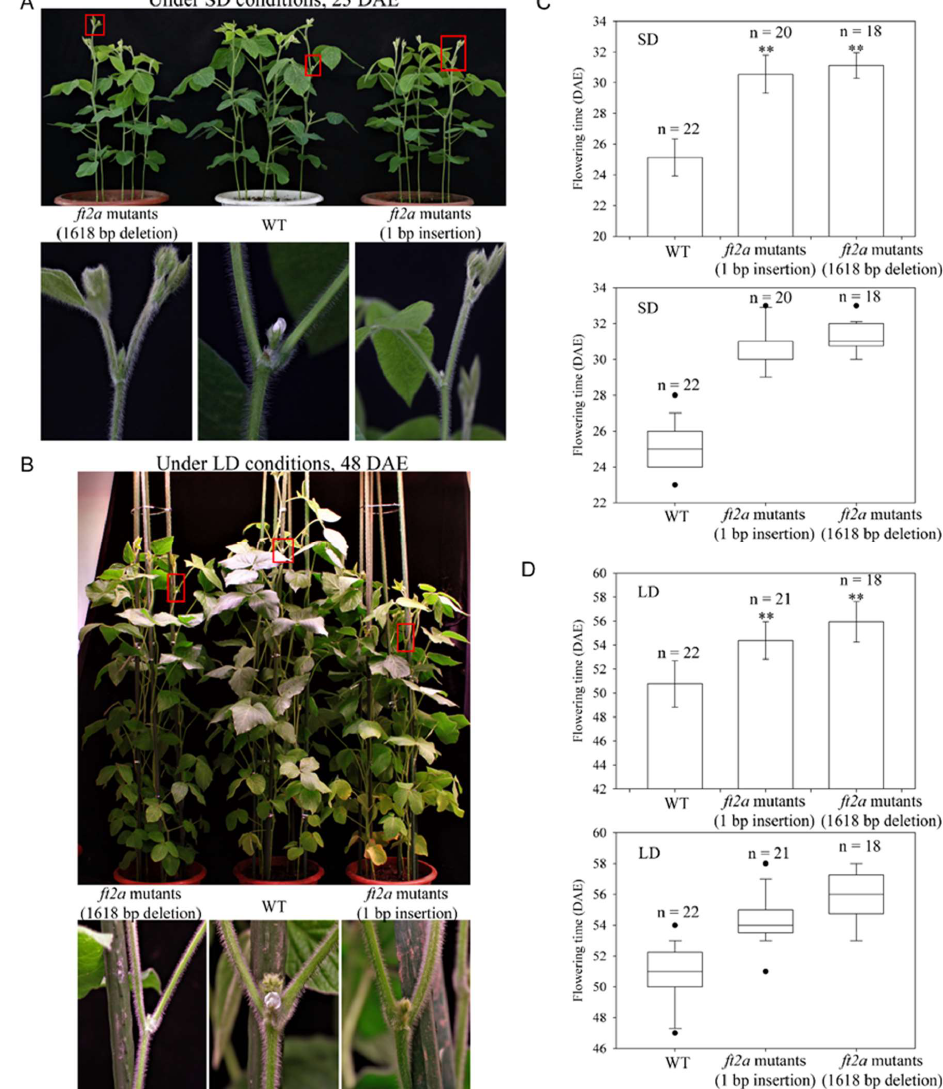
Figure 4. The ft2a mutants homozygous for large fragment deletions exhibited late flowering under both long-day (LD) and short-day (SD) conditions. ( A , B ) Flowering phenotypes of the ft2a mutants (1618 bp deletion), WT plants, and the ft2a mutants (1 bp insertion) under SD and LD conditions, respectively. Red box, magnified view. DAE, days after emergence. ( C , D ) Boxplots and bar plots indicating flowering time of the ft2a mutants (1618 bp deletion), WT plants, and the ft2a mutants (1 bp insertion) under SD and LD conditions, respectively. n , exact number of individual plants identified. The flowering time is shown as the mean values ± standard deviation. ** both ft2a mutants (1618 bp deletion) and the ft2a mutants (1 bp insertion) exhibit highly significant late flowering ( p <